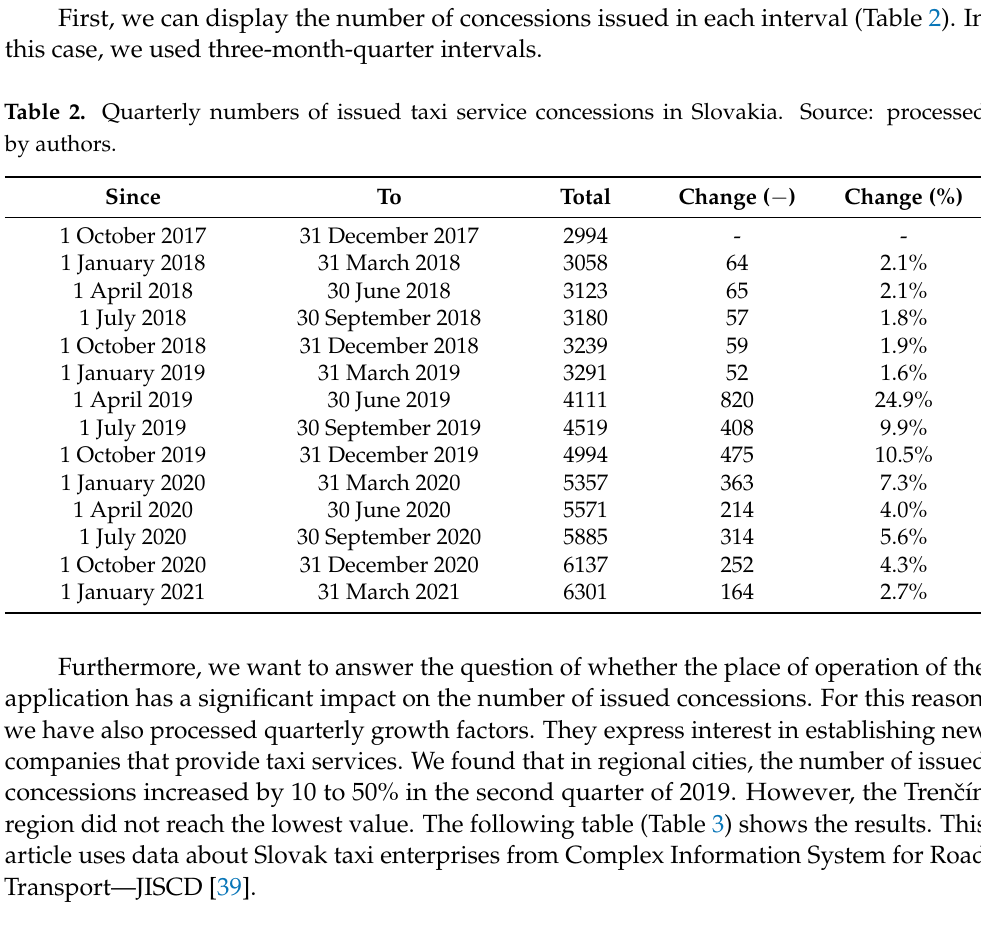
Table 3. Increase in issued concessions in individual regions. Source: processed by